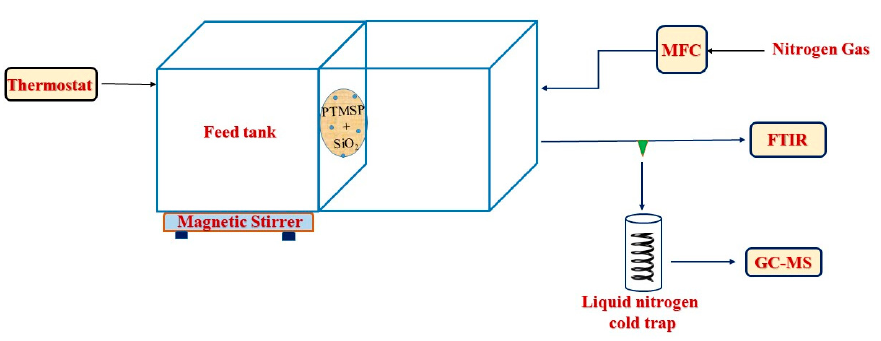
Figure 2. Schematic drawing of the pervaporation apparatus.